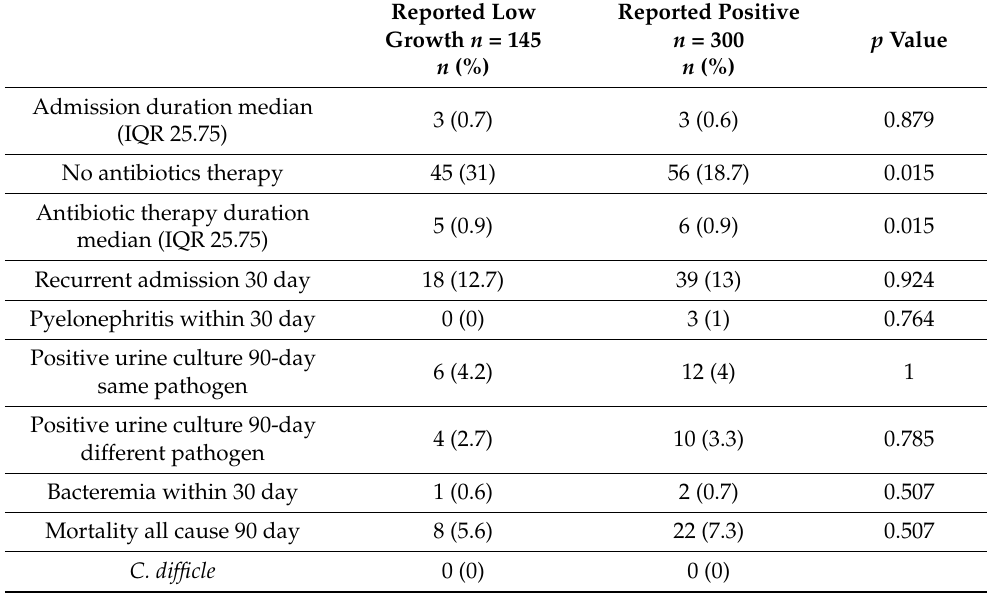
Table 5. Comparison of patient outcomes with urine cultures that were reported as low growth to patients that were reported as